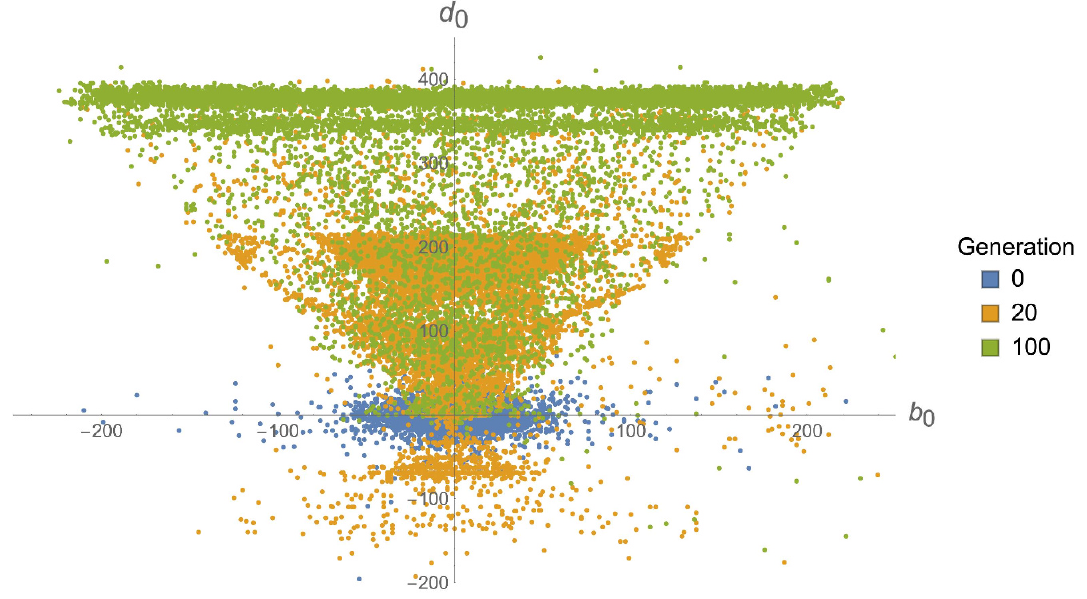
Figure 13 . Flux distribution for the two (almost) unconstrained (cid:13)uxes b 0 , d 0 in the (cid:12)nal